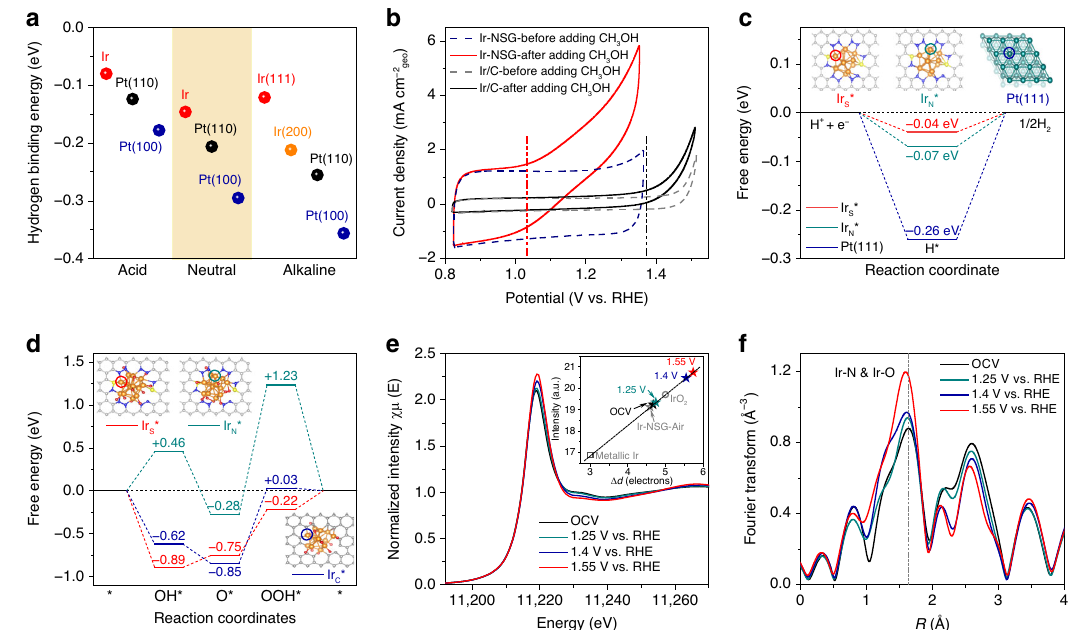
Fig. 3 Free-energy calculations and operando X-ray absorption spectroscopy. a Comparison of HBE for Ir-NSG and Pt/C in a full range of pH. b Steady- state CV curves of Ir-NSG and Ir/C in 1 M PBS with (solid line) and without (dotted line) 0.1 M methanol recorded at a sweep rate of 50 mV s − 1 . The dash- dot lines serve as the base for the onset potential of methanol oxidation. c DFT calculation of the predicted free-energy diagrams for HER at U = 0 V on Ir S *, Ir N *, and Pt (111). d DFT calculation of the predicted free-energy diagrams for OER at U = 1.23 V on Ir S *, Ir N *, and Ir C * sites. The balls in gray, blue, yellow, pink, red, orange, and cyan represent C, N, S, H, O, Ir, and Pt atoms, respectively. e Normalized operando Ir L 3 -edge XANES spectra at various biases (applied potential versus RHE) in 1 M PBS at ambient conditions. Inset shows integrated WL intensities as a function of 5 d -band holes derived from Supplementary Fig. 30, ex situ data for Ir/C, Ir-NSG, and IrO 2 are provided as the reference. f k 2 -weighted Fourier transform magnitudes of EXAFS spectra collected at the Ir L 3 -edge of Ir-NSG under various potential biases. The dash-dot lines serve as the eye guide for comparison of the Ir-N (O) bond length. All data were collected with i – R